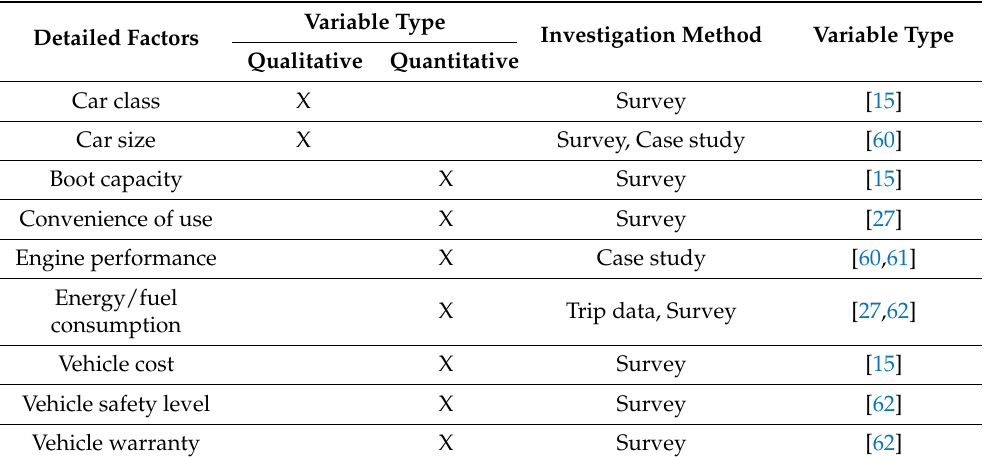
Table 5. Factors related to car-sharing fleet.